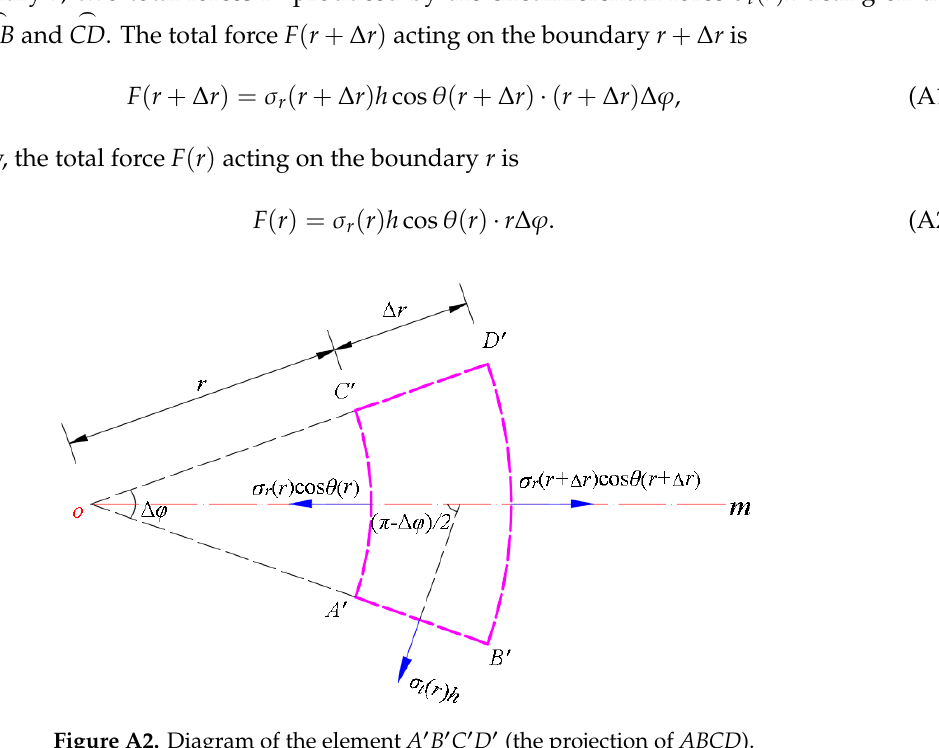
Figure A2. Diagram of the element ABCD (the projection of ABCD ).